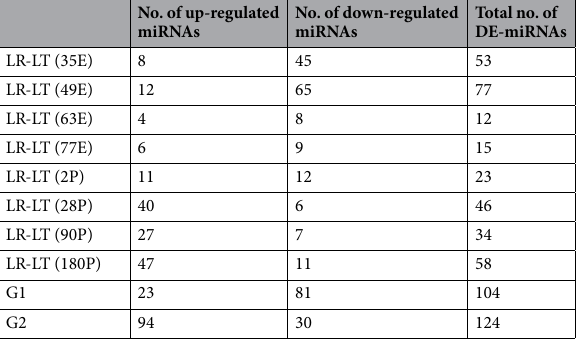
Table 1. Summary of significantly DE-miRNAs between breeds by stage and group. E represents embryonic stages and P represents postnatal stages.